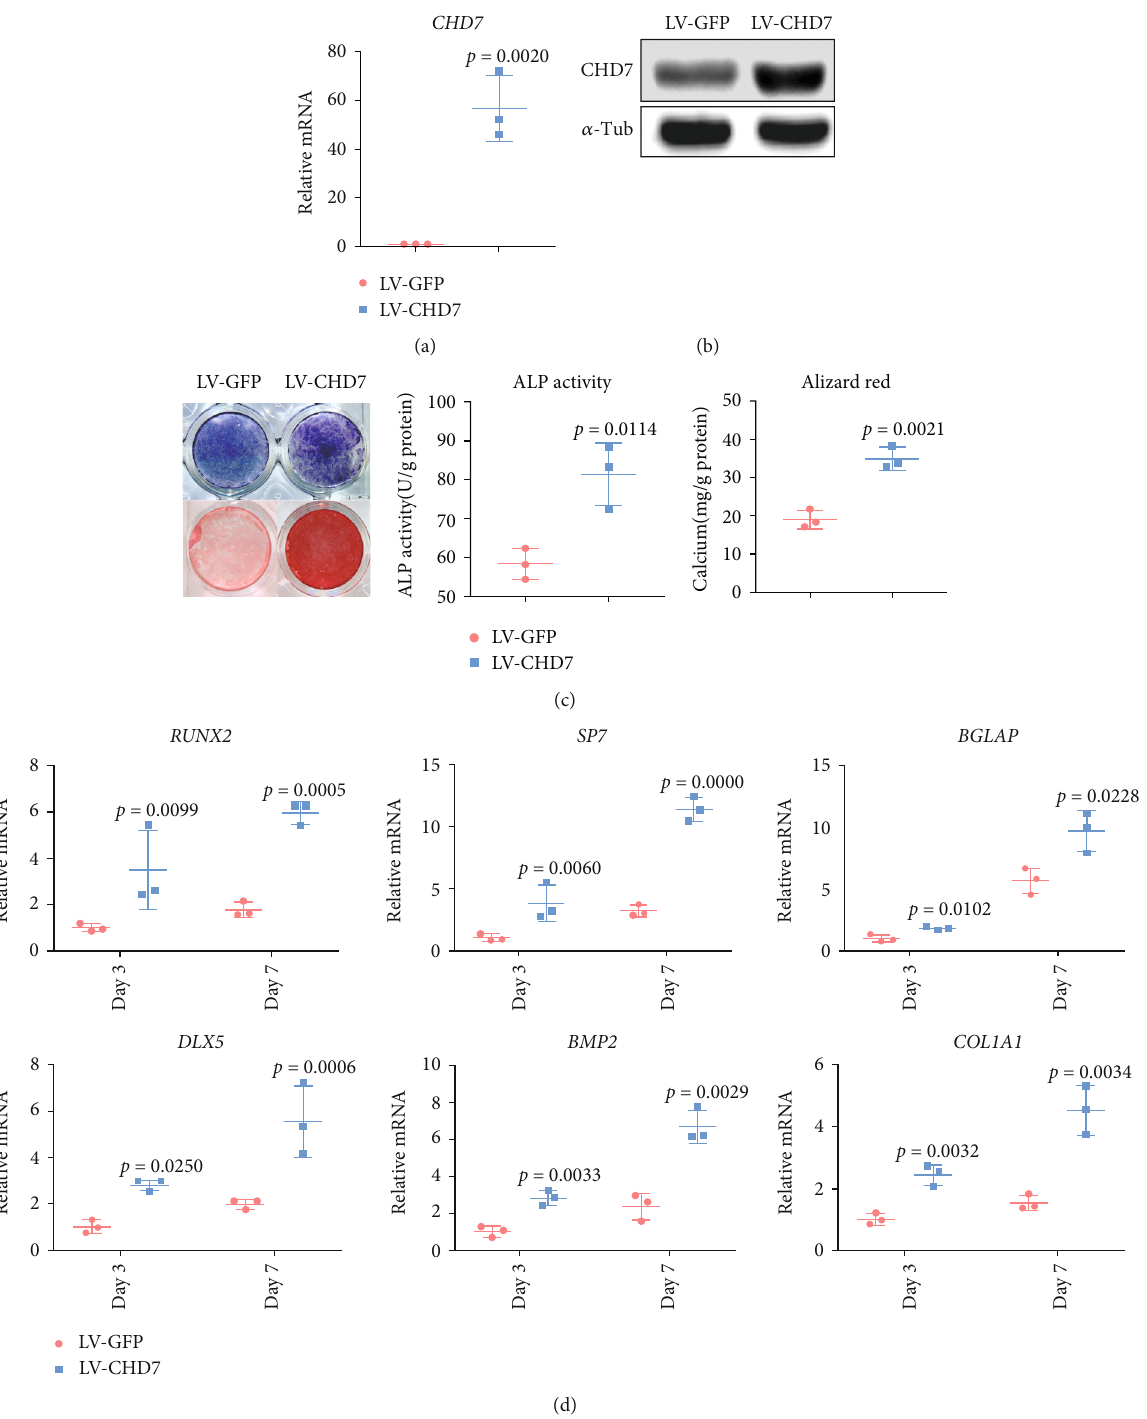
Figure 3: The overexpression of CHD7 promotes osteogenic di ff erentiation of hDFCs. (a), (b) qRT-PCR and Western blot veri fi ed the overexpression e ffi ciency of CHD7 . (c) Representative images and quantitative analyses of ALP and ARS staining of hDFCs in the LV- CHD7 and LV-GFP group. (d) qRT-PCR analyses of the expression of RUNX2 , SP7 , BGLAP , DLX5 , BMP2 , and COL1A1 under osteogenic